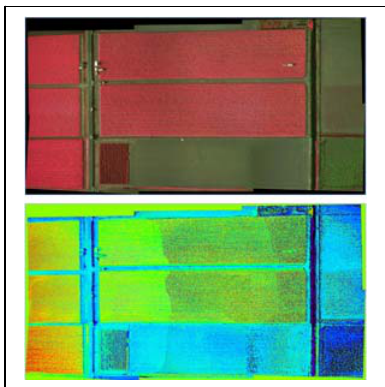
Figure 9. A comparison of curled mosaic strip correction. Left image is the mosaic generated based on image features only. Right image shows curling effect has been alleviated, control information are applied to fix two ends of strip, and accumulation errors are spread evenly over the strip.